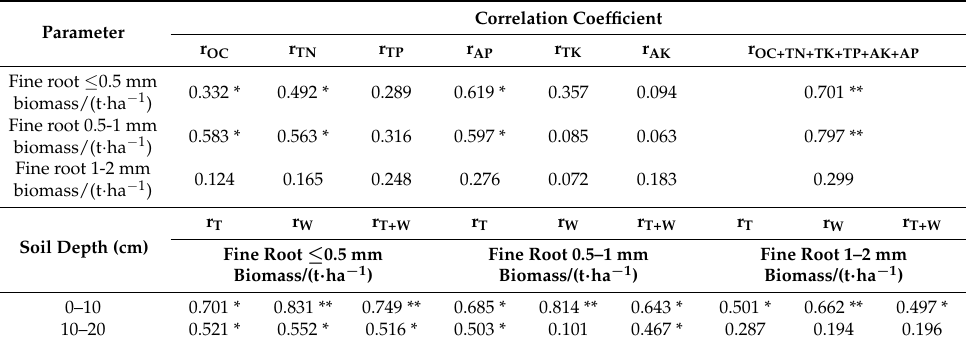
Table 2. Correlation coefficients for the relationship between the fine root biomass of P. massoniana and soil nutrients at a depth of 0–30 cm and soil temperature and moisture at depths of 0–10 and 10–20 cm. ** and * indicate that the correlation is significant at the 0.01 and 0.05 levels, respectively. Correlation Coefficient Parameter r OC r